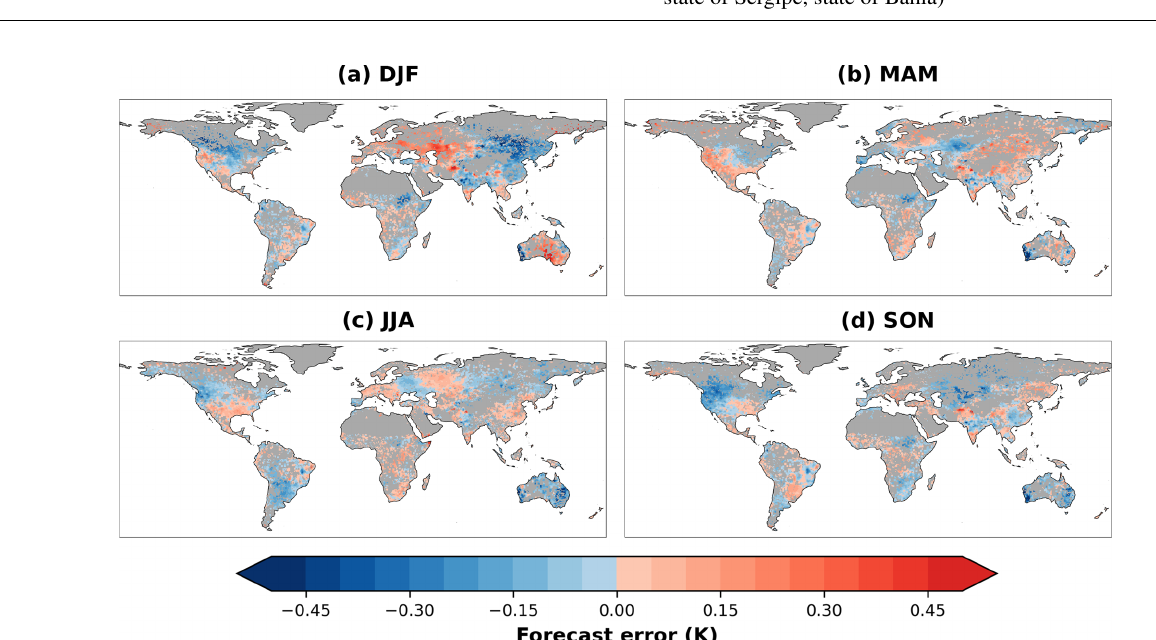
Figure 2. Seasonal averages (DJF, MAM, JJA, SON) of temperature forecast error. Regions with gray color are masked out of the entire analysis due to (i) low observational data density (Fig. A1) or (ii) the Benjamini–Hochberg procedure (Sect.